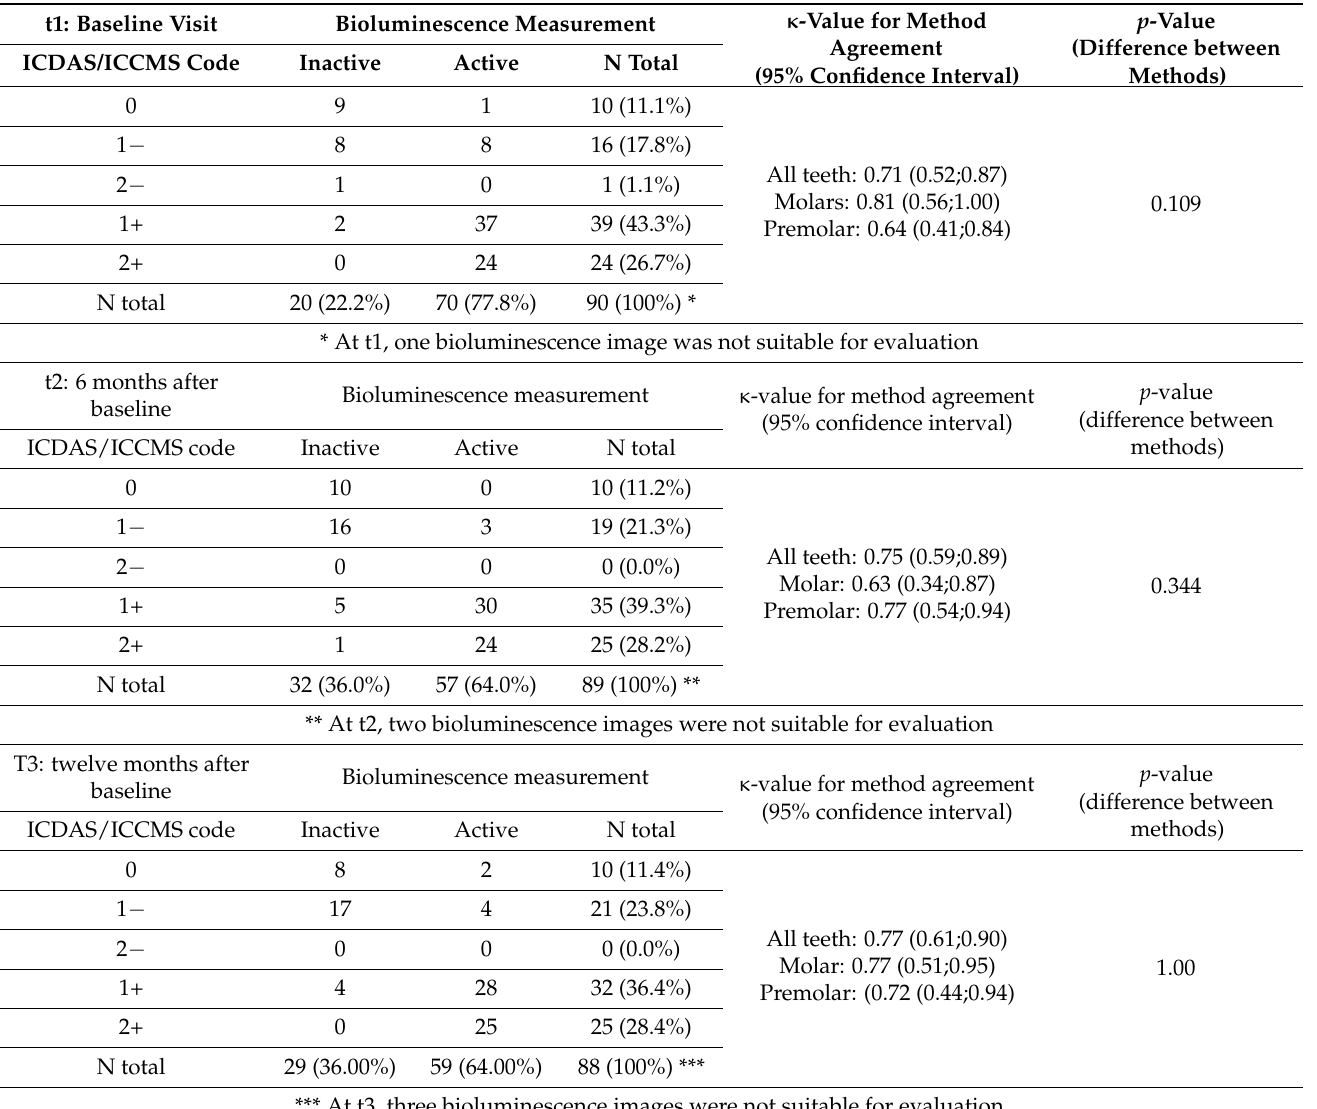
Table 2. Distribution of visual caries codes cross-tabulated with the results of the bioluminescence measurements. The prefix + or - indicates an active or inactive lesions according to the visual criteria. Fields with agreement between the findings are highlighted in